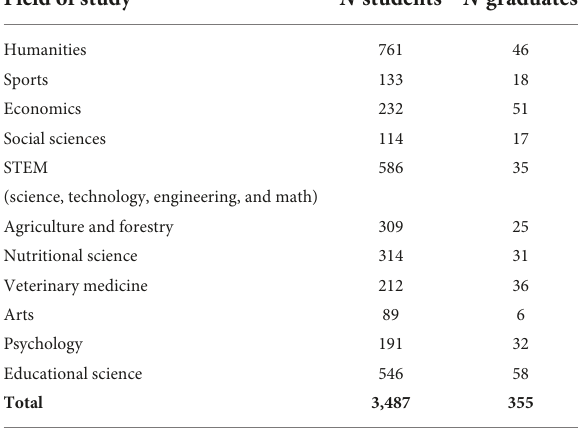
TABLE 1 Distribution of fields of